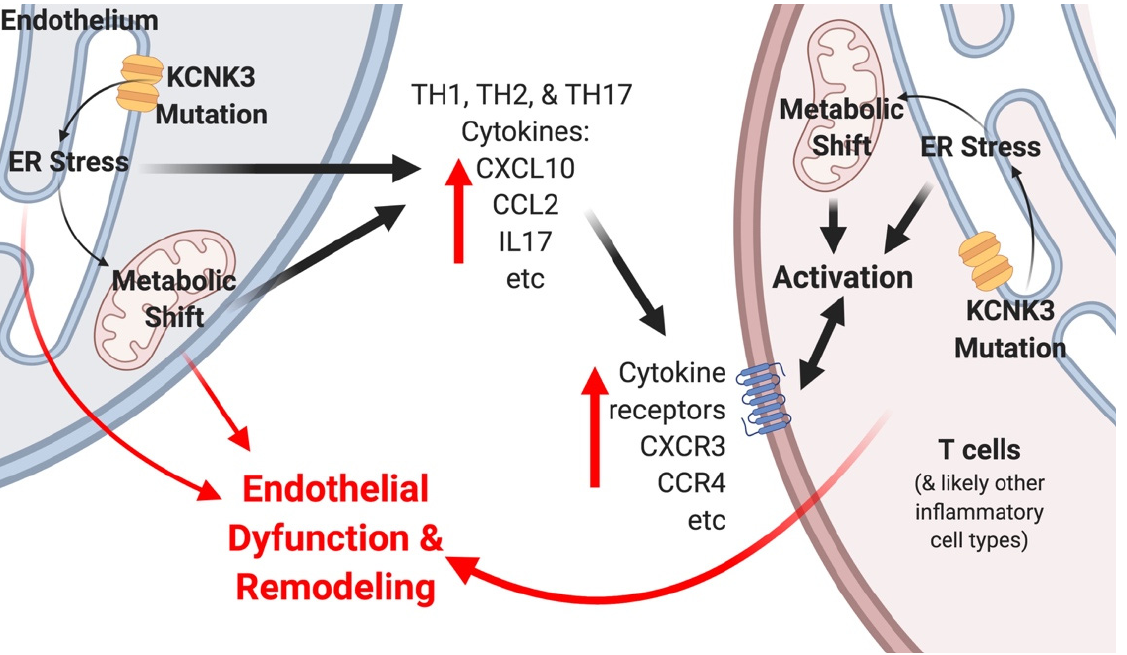
Figure 7. Schematic representation consistent with study outcome, other studies of KCNK3 in pulmonary hypertension, and studies of the role of KCNK3 in the endoplasmic reticulum and other literature. Figure created with BioRender.com (Toronto, Ontario, Canada).